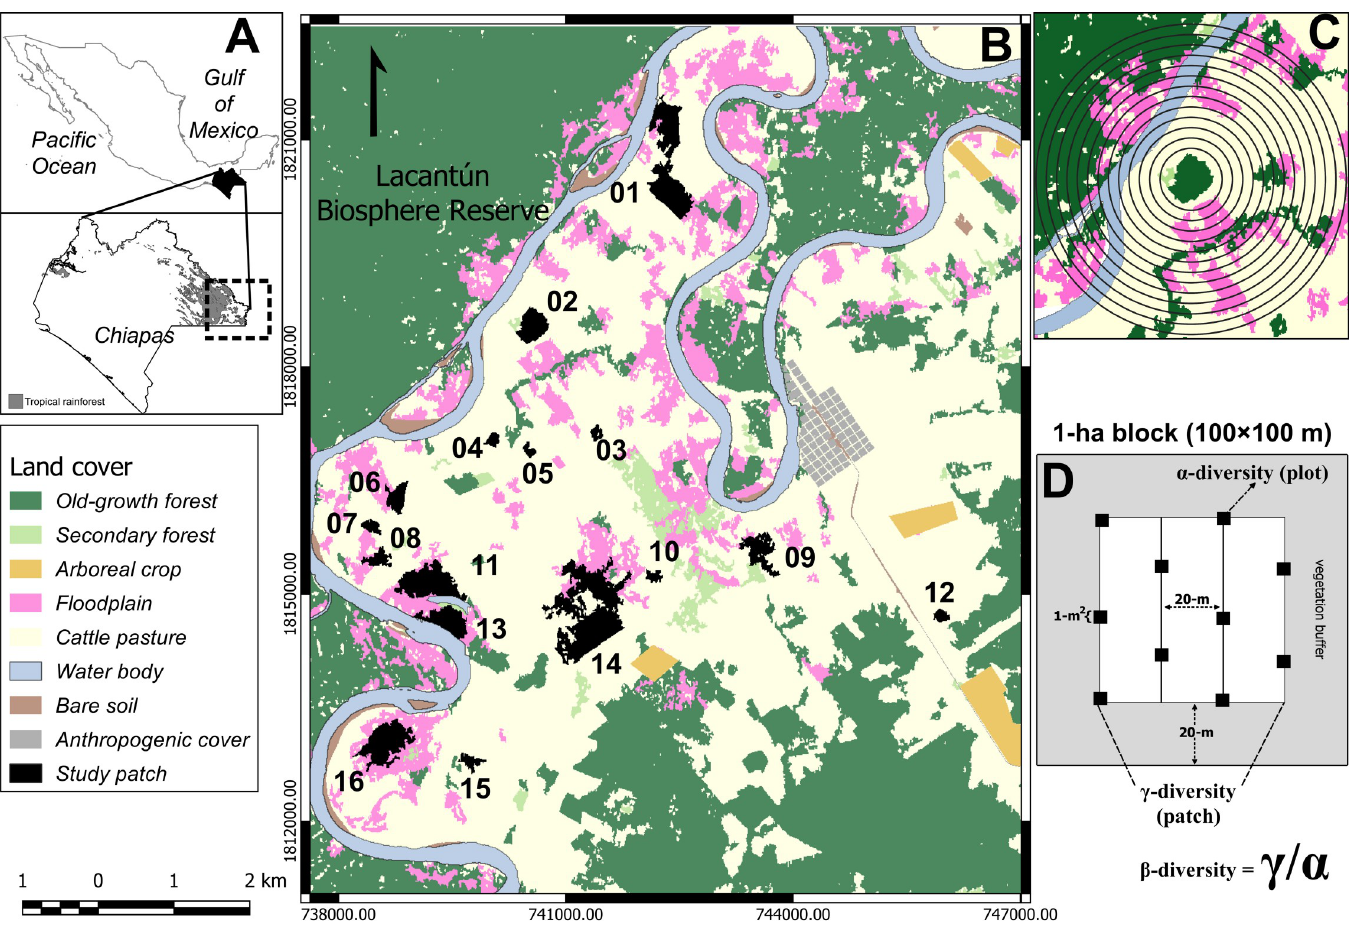
Fig 1. Study site and sampling design of tree seedlings. The figure shows the location of the study area (A) and the 16 study patches (black) in the Marque´s de Comillas region (B). The 13 buffer sizes around the geographic center of the sampling block (C). Sampling method of tree seedlings (see material and methods), and the source of γ - diversity (species located in the 1-ha block), α -diversity (the average number of species per 1-m2 plot) and β -diversity (the effective number of completely distinct assemblages within each 1-ha block) (D). Reprinted from [55] under a CC BY license, with permission from Sergio Nicasio-Arzeta, original copyright 2019.